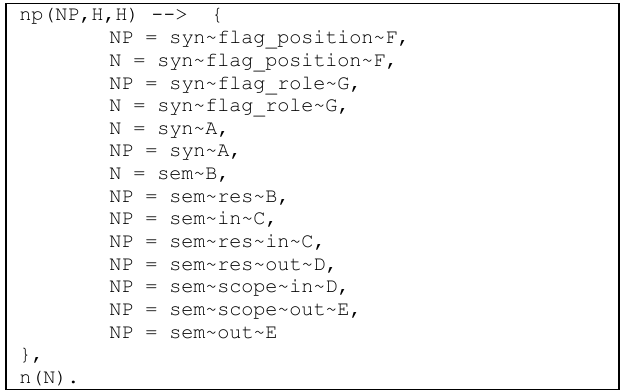
Figure 6. Analyze the noun phrase based on framework GULP (Source: T. Tran and D. T. Nguyen